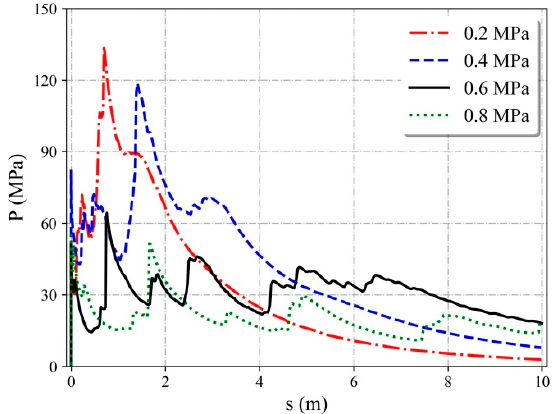
Figure 14. Simulated projectile base pressure versus the projectile travel distance for different pump tube pressure at a detonation pressure of 3.0 MPa.